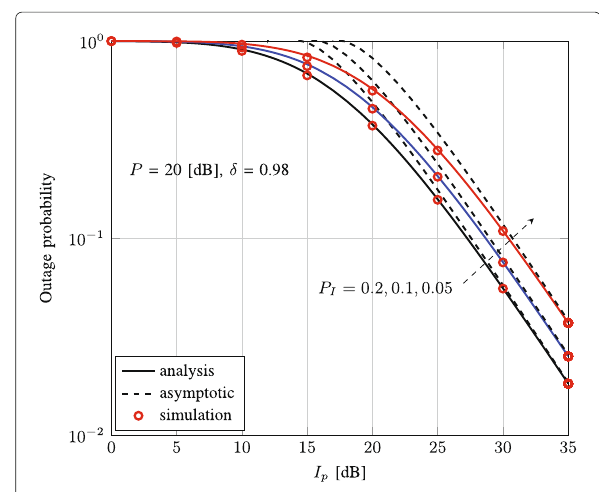
Fig. 4 Effect of P I on the secondary system outage